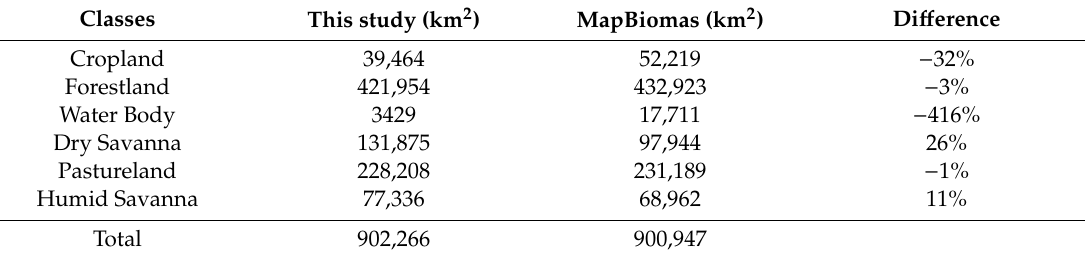
Table 5. Comparison of the areas mapped by this study and by the MapBiomas